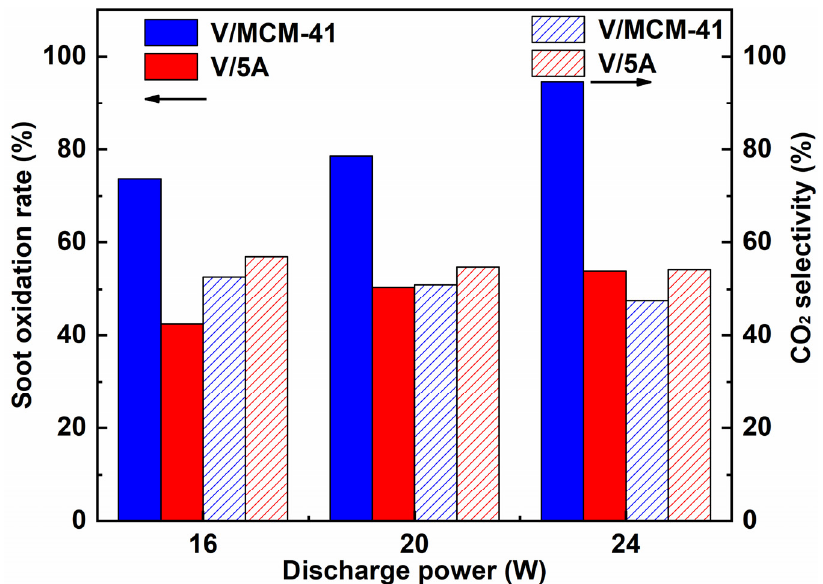
Figure 6. Effect of discharge power on soot oxidation rate and CO 2 selectivity of plasma-catalytic soot oxidation at 30th min over V/MCM-41 and V/5A catalysts (Gas flow rate: 500 mL ∙ min − 1 and reaction temperature: 25 °C).